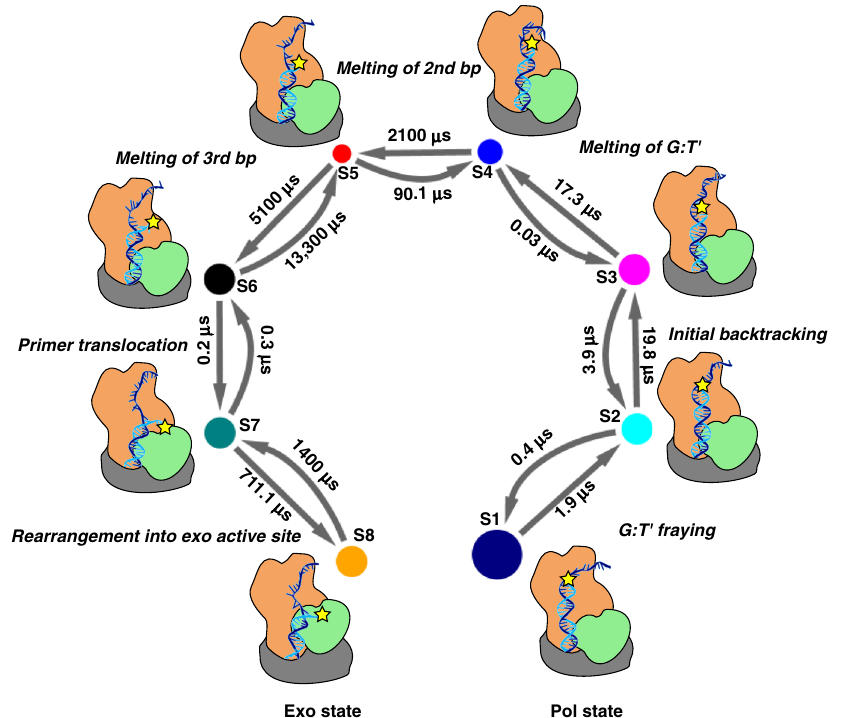
Fig. 4 Complete kinetic model for the pol-to-exo mode transition connecting all on-path intermediates identi fi ed by the MEMM analysis. Macrostates S1 – S8 are denoted by circles. Larger circles correspond to more populated macrostates. Transition between states are indicated with arrows and computed timescales for transitioning in and out of each macrostate are shown above the arrows. Each microstate is also represented by a cartoon, indicating the position and the extent of unpairing of the DNA primer end. The position of the mismatch nucleotide on the primer strand is indicated by a yellow